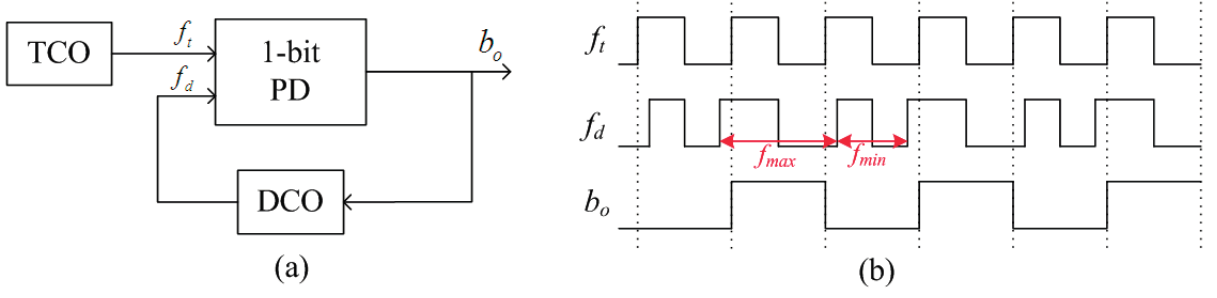
Figure 1. PLL-based temperature sensor; ( a ) architecture; ( b ) corresponding waveforms in locked